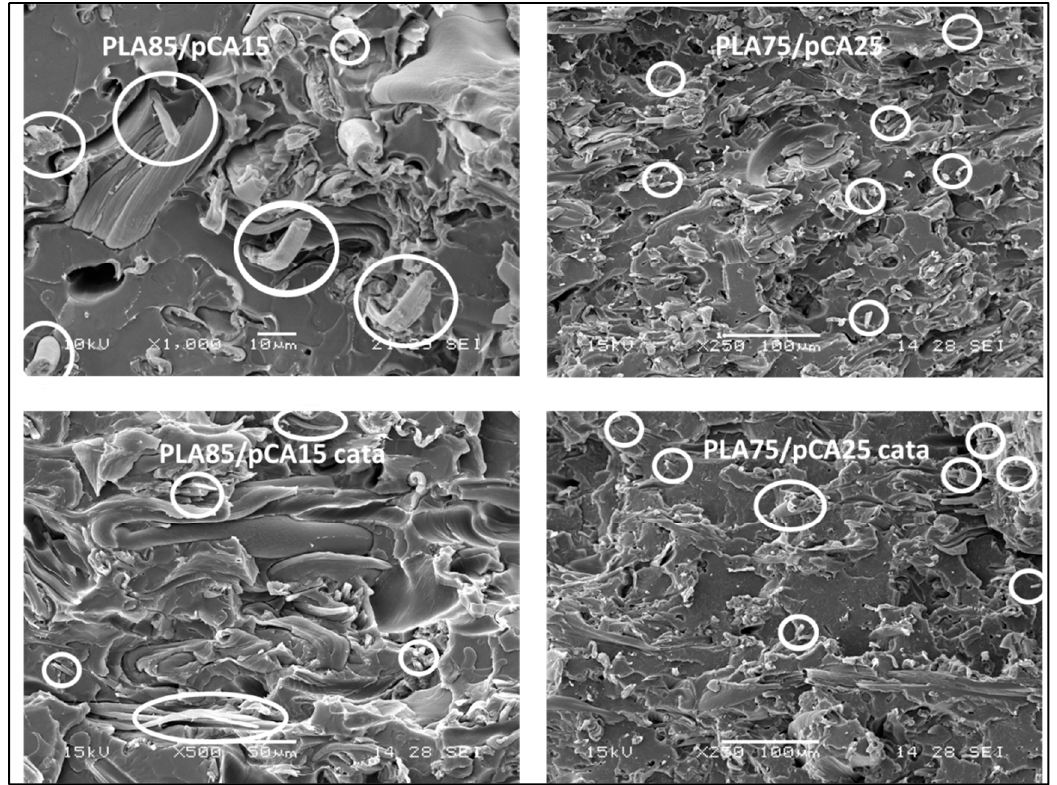
Figure 9. Scanning electron micrographs where single fibres are indicated by circles. The micrographs are related to the PLA/pCA 85/15 and 75/25 blends prepared at 197 °C.